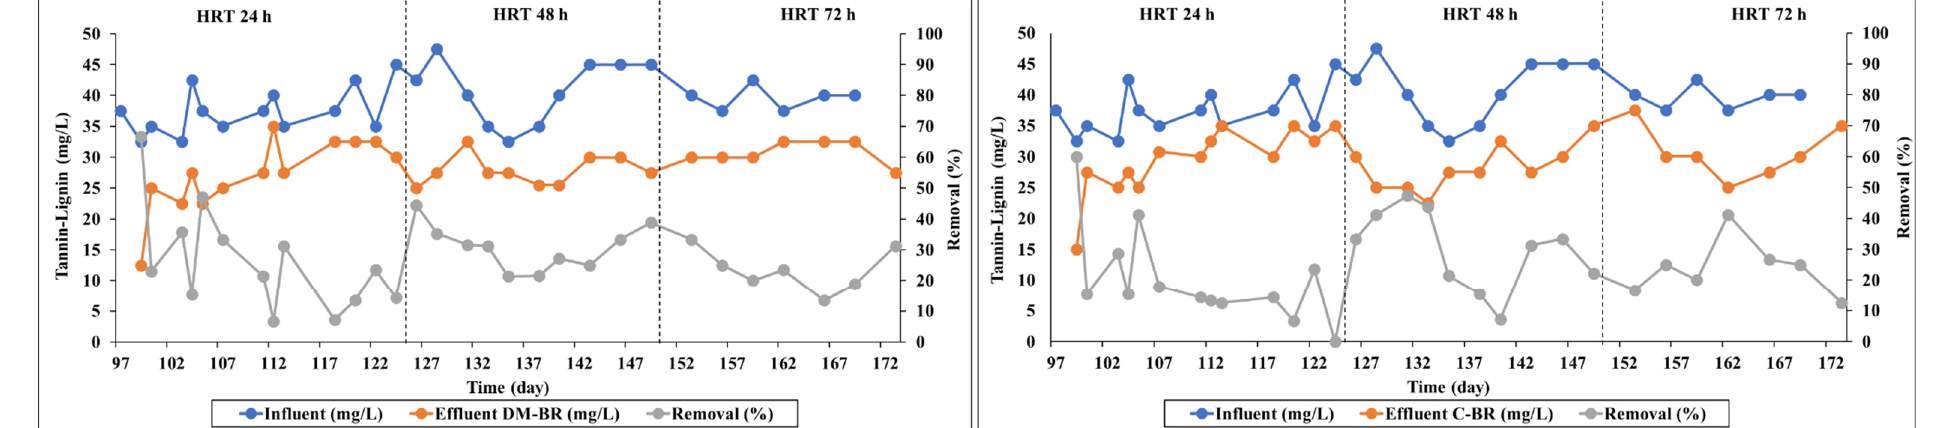
Figure 2. Removal of tannin–lignin in the DM-BR ( left ) and the C-BR ( right ).